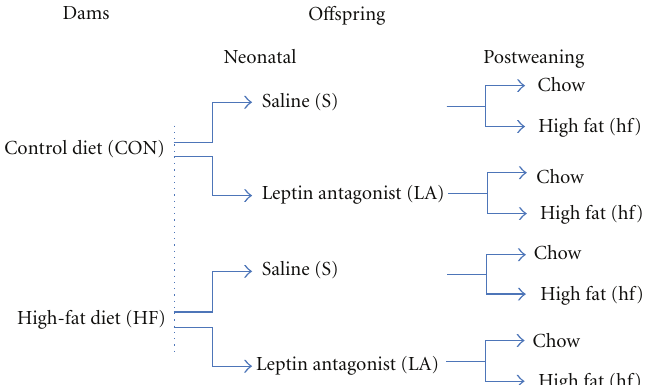
Figure 1: Schematic showing experimental design. There are two levels of maternal nutrition, 2 levels of neonatal treatment, and 2 levels of postweaning diet resulting in a total of 8 experimental groups in a fully balanced 2 × 2 × 2 design.